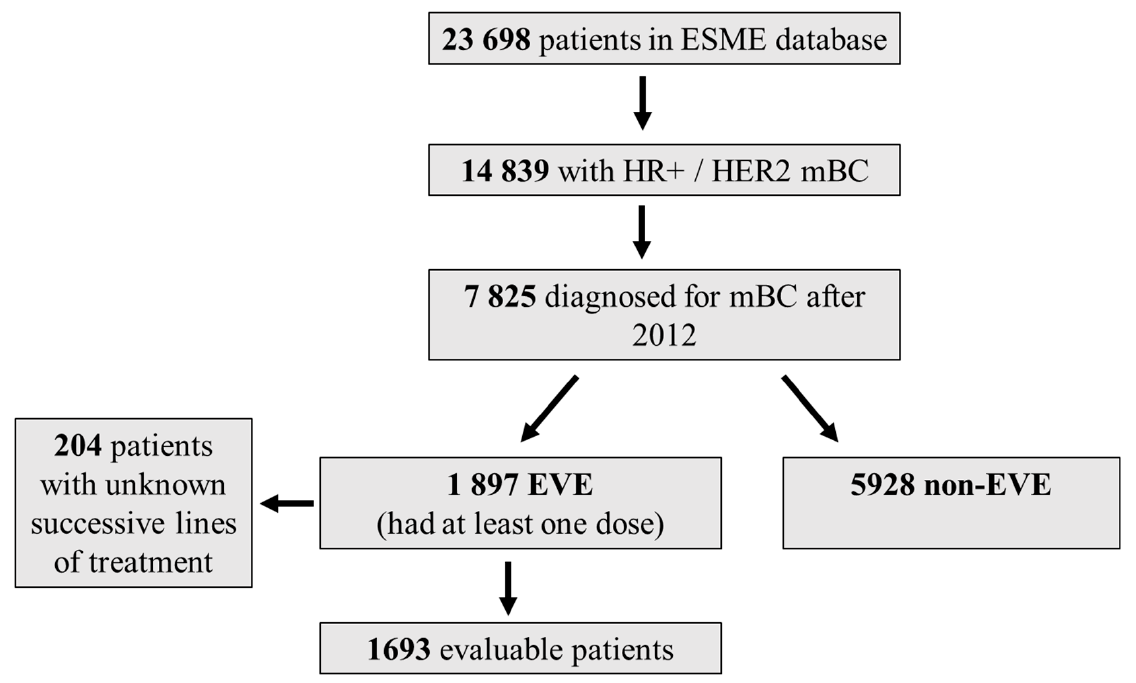
Figure 1. Patient disposition. Patient characteristics at metastatic diagnosis and at the start of each therapeutic line are detailed in Table 1 and in Tables 2–4. Table 2. Patient characteristics at the initiation of line